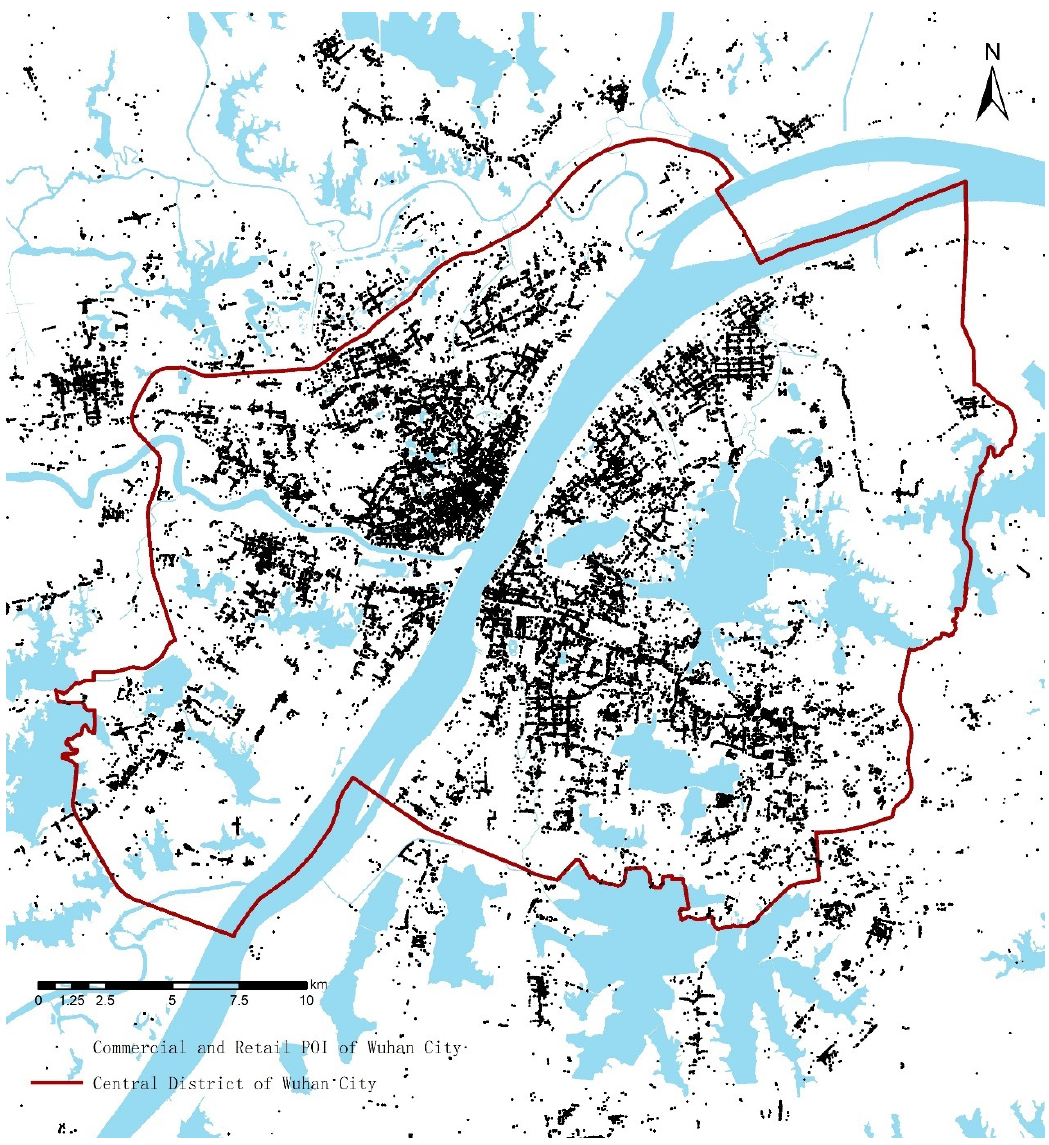
Figure 4. Commercial and Retail POI data of Wuhan.